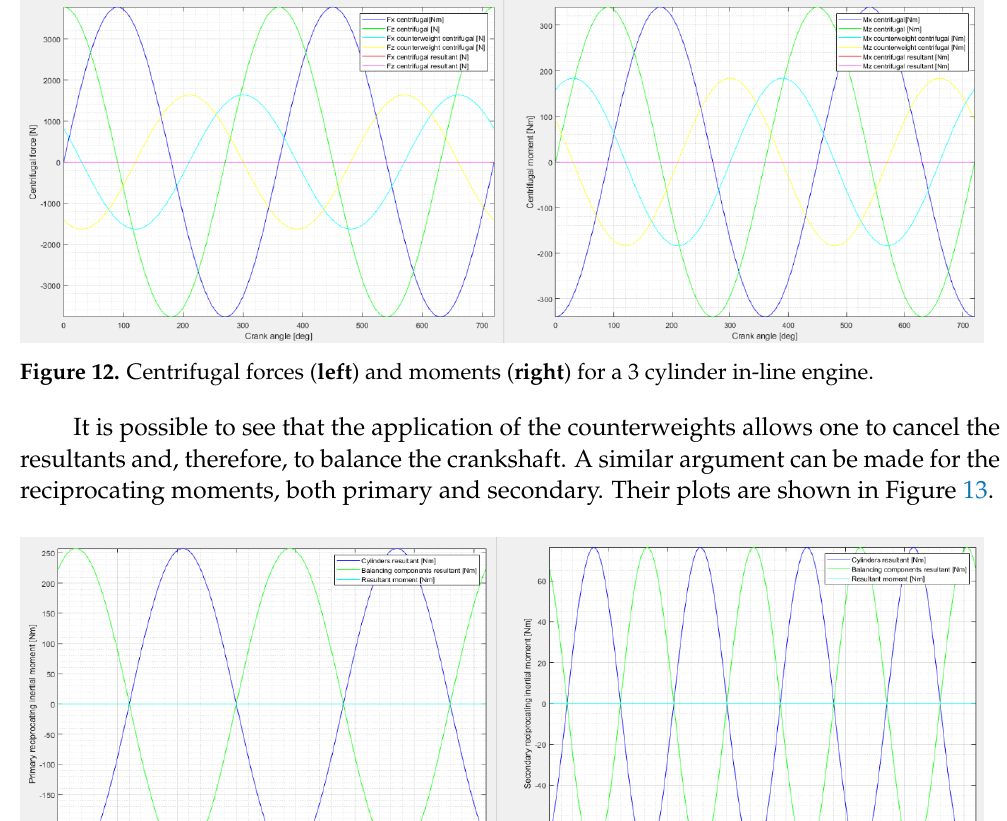
z components, are reported in Figure 12.